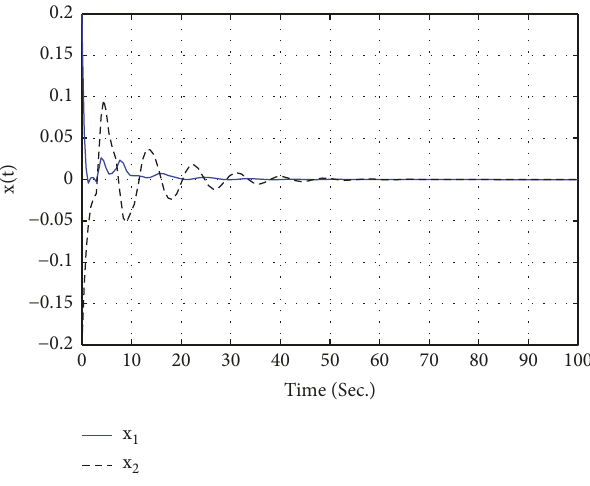
Figure 1: The state responses for Example